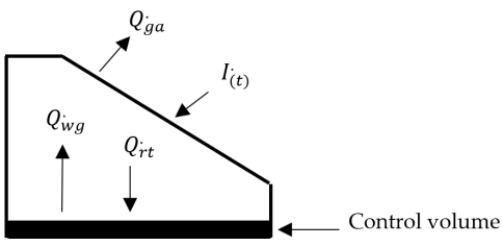
Figure 4. Initial energy balance in the solar still. The arrows indicate the direction of heat input and loss in the basin water (volume control) and in the glass cover of the solar still. To perform the energy balance in the solar still, we considered the following assump- tions [20], namely: